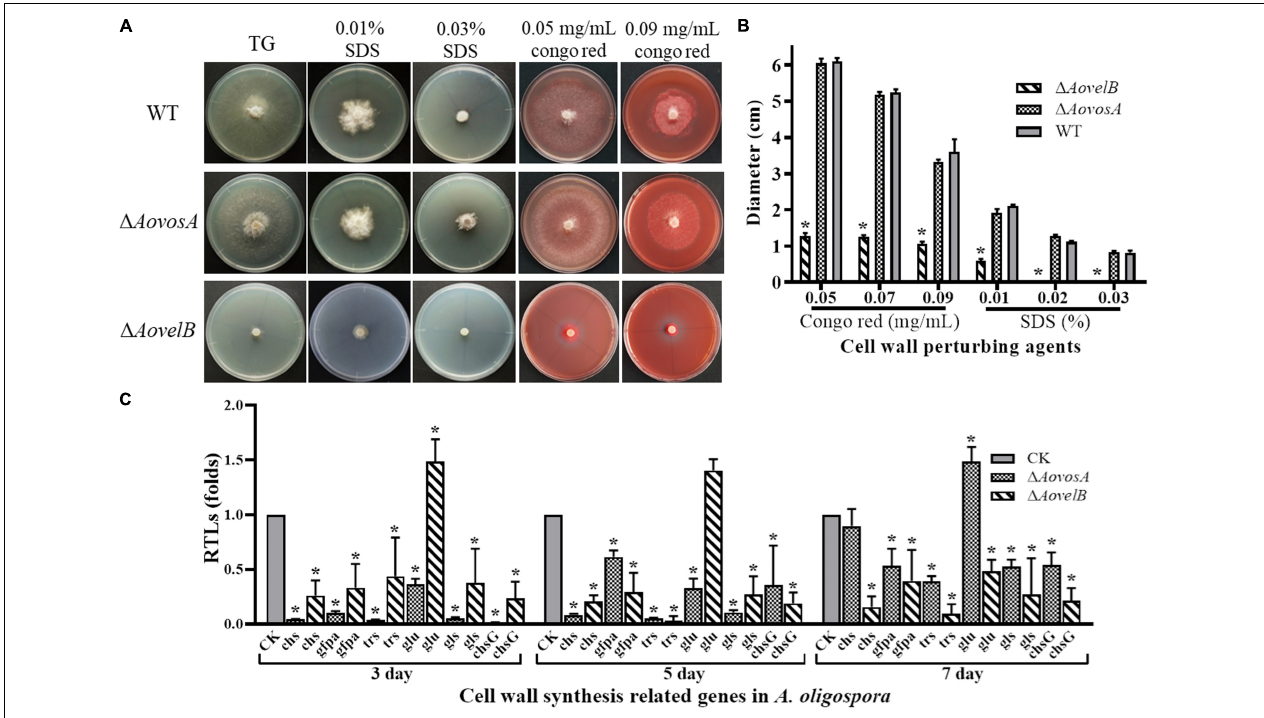
FIGURE 5 | Comparison of stress tolerance to cell wall perturbing agents. (A) Colony morphology of the WT and mutants incubated on TG medium supplemented with sodium dodecyl sulfate (SDS) or Congo red. (B) The colony diameters of the WT and mutants after incubated on TG medium supplemented with 0.01–0.03% SDS or 0.05–0.09 mg/mL Congo red for 5 days. (C) Relative transcriptional levels (RTLs) of cell wall synthesis-related genes in the mutants compared with the WT strain at different time points. CK. The level of each gene was computed as a ratio of the transcript level of the gene in the deletion mutant to that in the WT strain under a given condition. An asterisk indicates a significant difference between the mutants and the WT strain ( p <